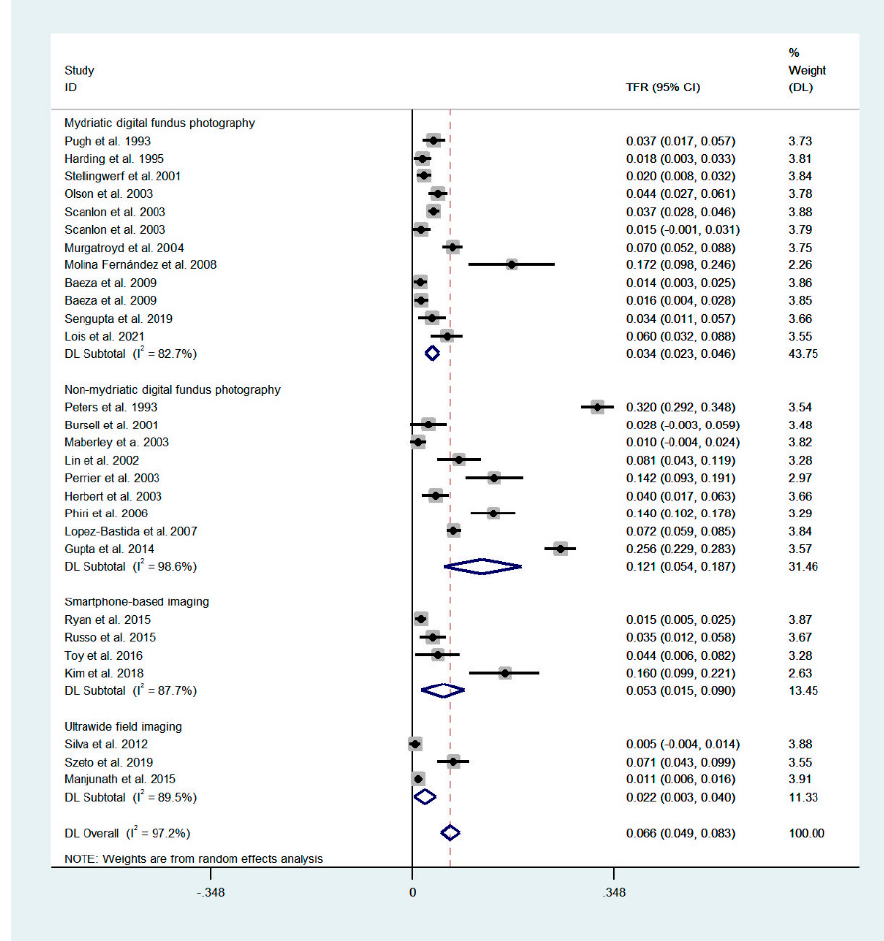
Figure 1. Forest plot presenting the technical failure of the analyzed techniques. Overall values for mydriatic fundus photography: 3.4% (95% CI: 2.3–4.6%, I 2 = 82.7%), for non-mydriatic fundus imaging: 12.1% (95% CI: 5.4–18.7%, I 2 = 98.6%), smartphone-based imaging: 5.3% (1.5–9.0%; I 2 = 87.7%), ultrawide-field imaging: 2.2% (0.3–4.0%; I 2 = 89.5%). Overall, for all techniques: 6.6% (4.9–8.3%; I 2 = 97.2%). Weights are calculated from random effects analysis.